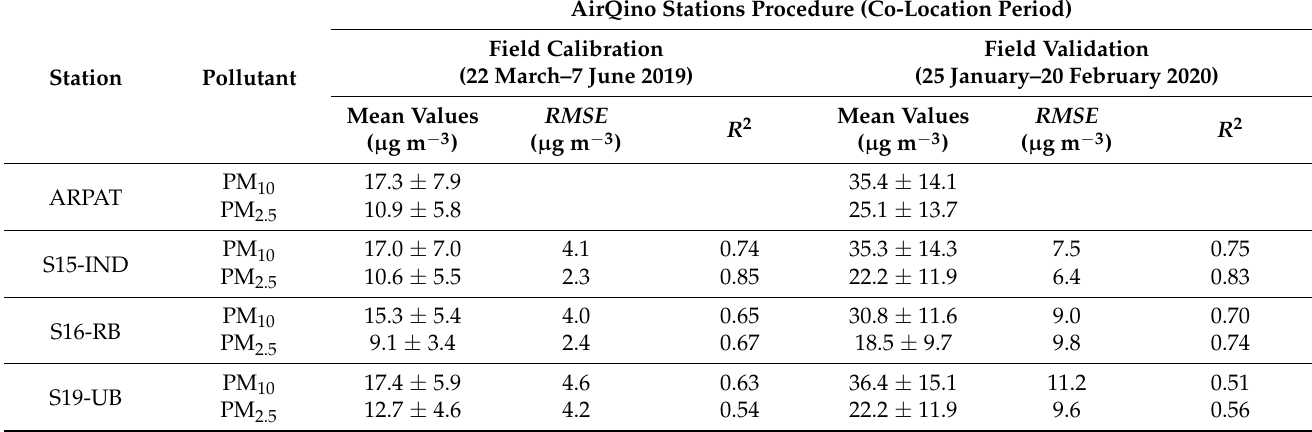
Table 2. Statistics of field calibration and field validation of AirQino stations against ARPAT reference station for PM 2.5